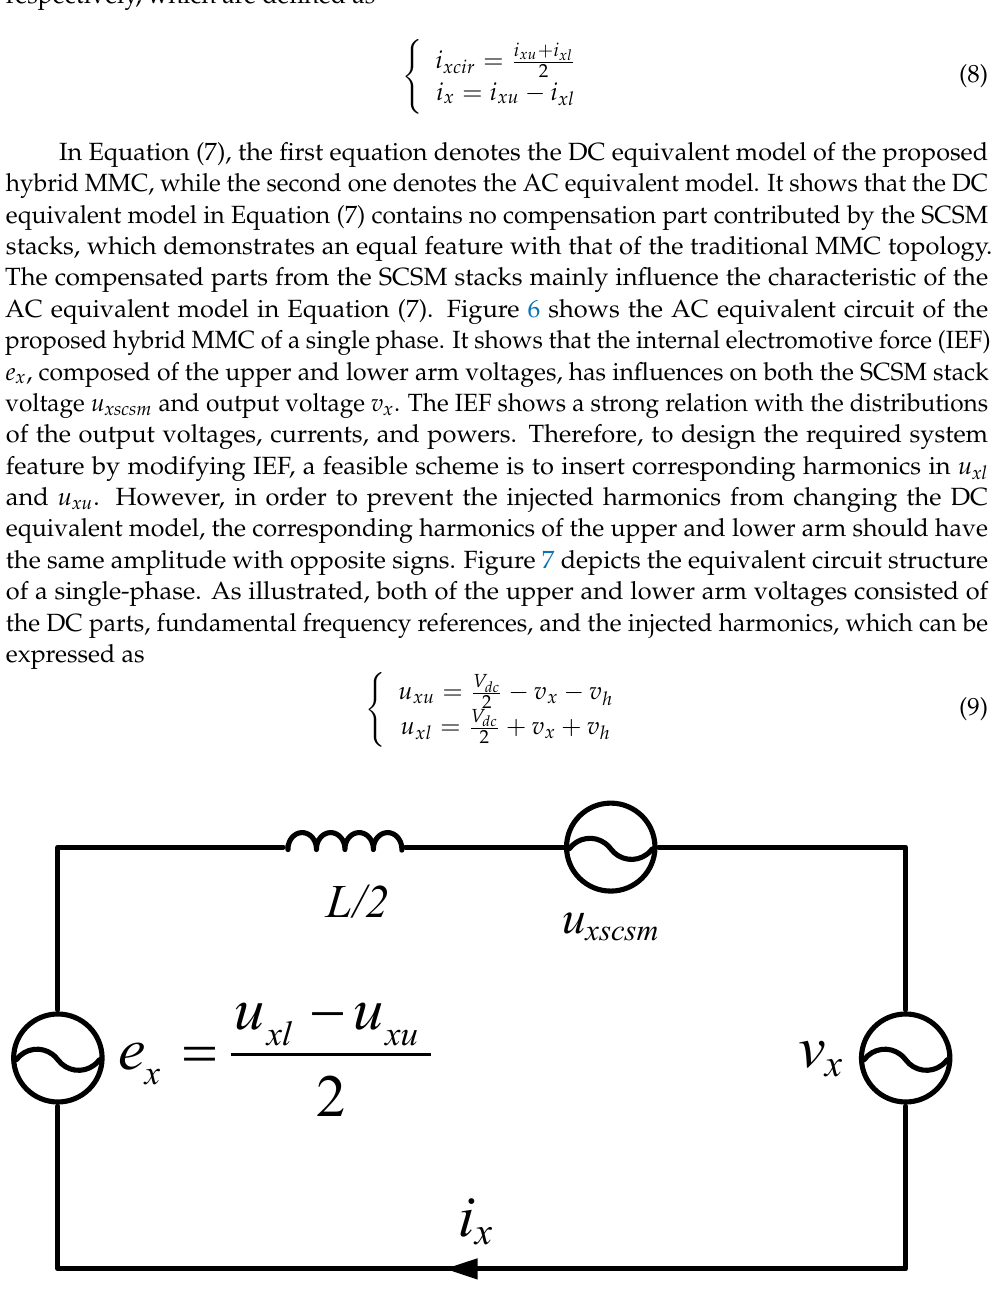
Figure 6. AC equivalent model of a single phase for the proposed topology .